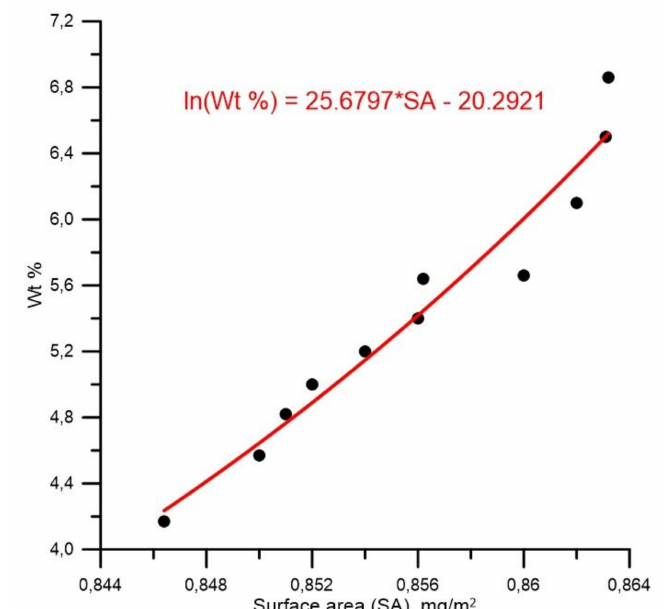
Figure 4. Hydrogen storage (wt %) versus surface area of graphene nanoblister sample at a temperature of 77 K and an external pressure of 1